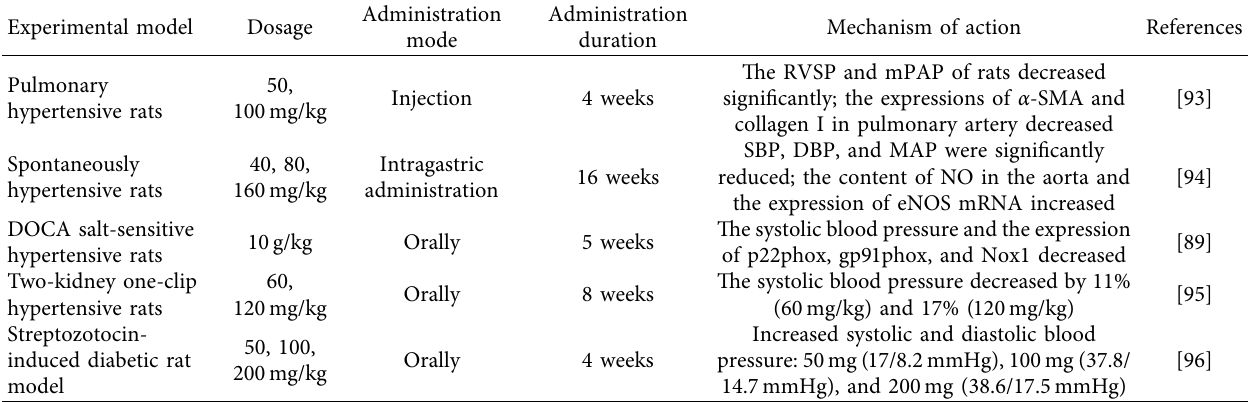
Table 5: Effects of sesamin on hypertension.